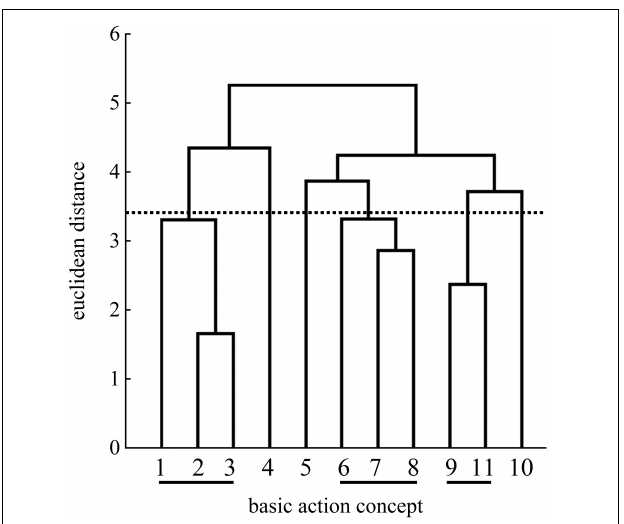
FIGURE 3 | Mean differences for velocity in km/h for the three groups from pretest to posttest, posttest to retention test, and from pretest to retention test. Error bars represent standard errors. TABLE 4 | Descriptive statistics for velocity in meters across the pretest, posttest, and retention test for the three groups.